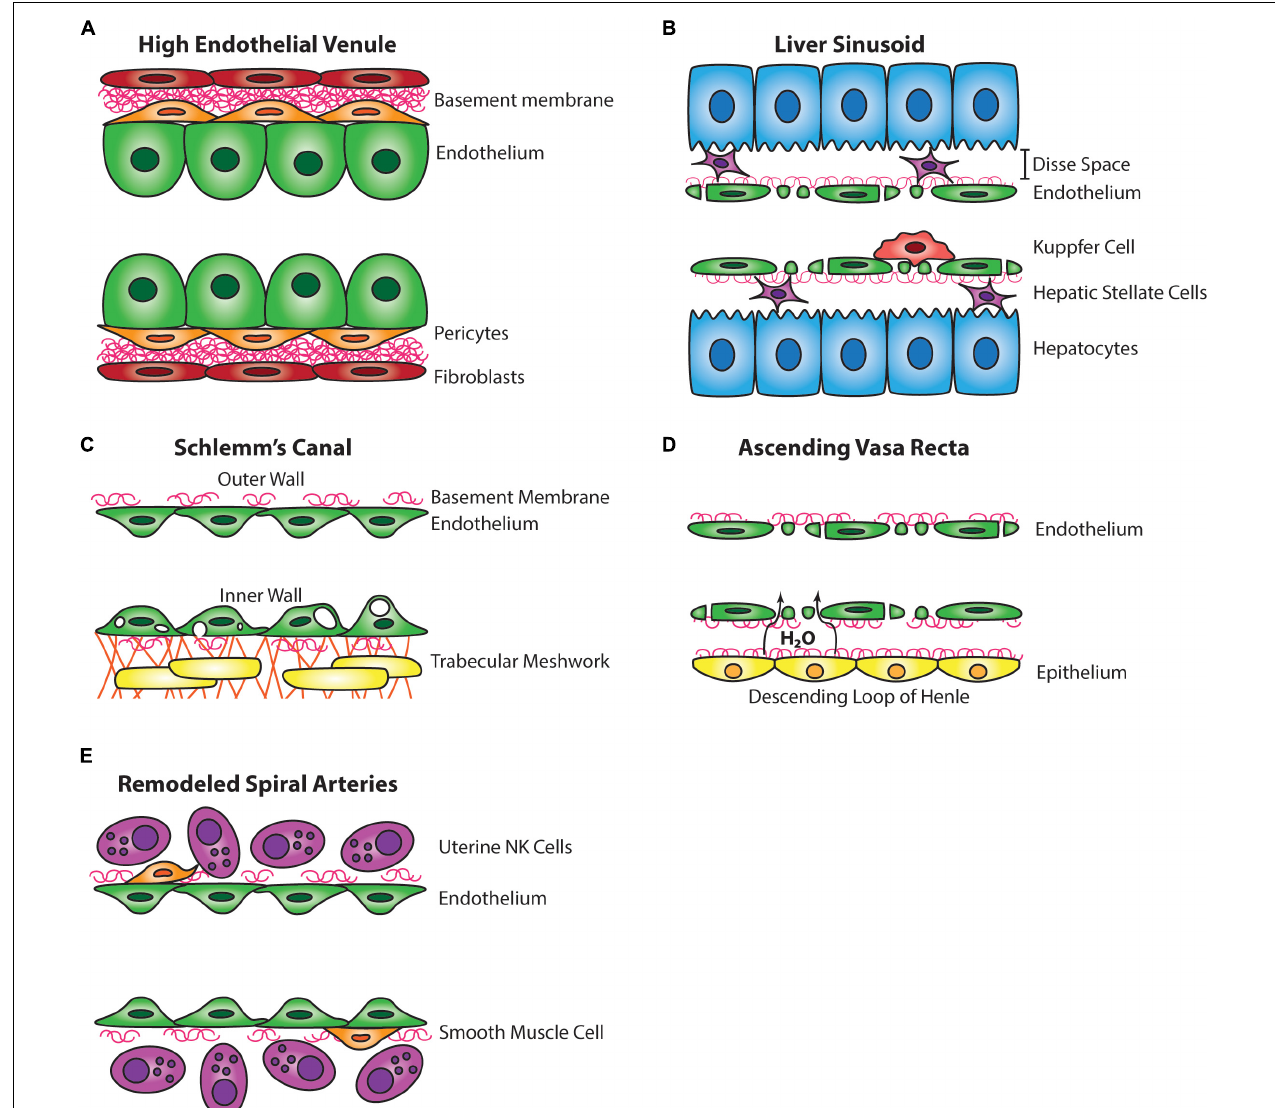
FIGURE 1 | Comparative wall structure of hybrid vessels. (A) The endothelial cells of high endothelial venules are tall and cuboidal and are associated with pericytes and a thick basement membrane. (B) The endothelium of the liver sinusoid is fenestrated, lacks mural cells, is supported by a thin basement membrane, and is associated with intraluminal Kupffer cells. The Disse space separates the liver sinusoid endothelium from hepatocytes and is inhabited by hepatic stellate cells. (C) The Schlemm’s canal has a discontinuous basement membrane, lacks mural cells, and the inner wall endothelium forms large vacuoles in response to aqueous humor flow from the trabecular meshwork. (D) The endothelium of the ascending vasa recta is fenestrated, lacks mural cells, and takes up water from the descending loop of Henle. (E) The endothelium of the remodeled spiral artery has minimal smooth muscle coverage, a discontinuous basement membrane, and closely associates with uterine NK